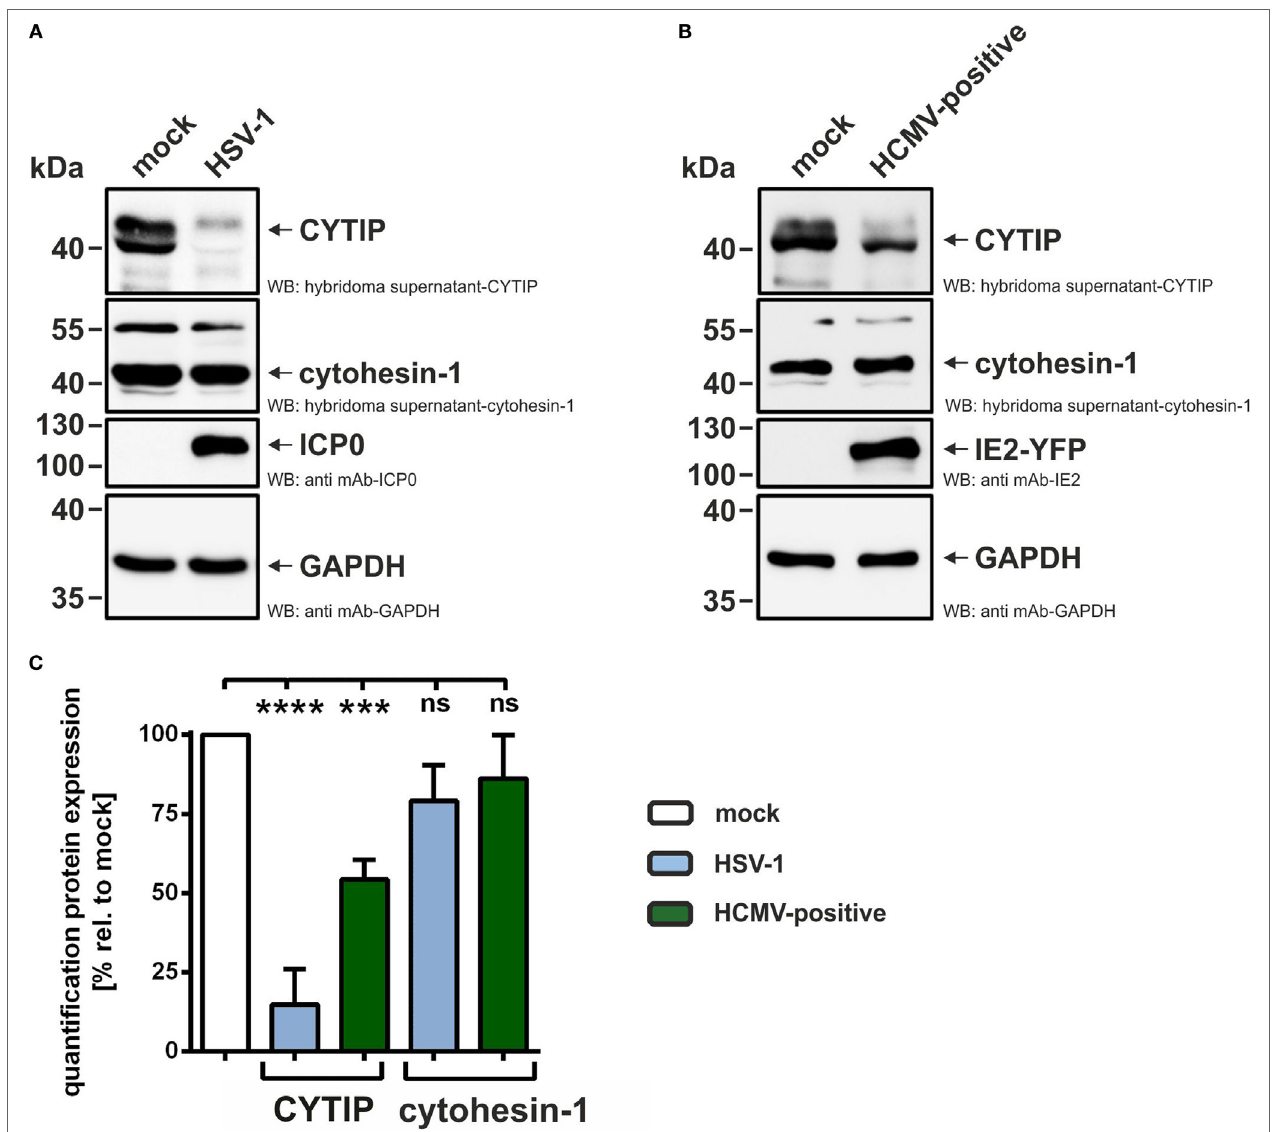
FigUre 4 | human cytomegalovirus (hcMV) infection of mature dendritic cells (mDcs) leads to decreased cYTiP expression levels . (a) mDCs were either mock- or herpes simplex virus type 1 (HSV-1)-infected and harvested 24 hpi, (B) mock- or HCMV-infected and sorted based on their green fluorescence protein expression 24 hpi. (a,B) Protein lysates were prepared and subjected to Western blot analyses with antibodies specific for CYTIP, cytohesin-1, ICP0, IE2, or GAPDH. One representative experiment out of at least three is shown. (c) Quantification of CYTIP and cytohesin-1 protein expression levels in HSV-1-infected or HCMV-positive mDCs, summarizing at least three independent experiments. Expression of CYTIP and cytohesin-1 was normalized to the GAPDH control. Mock was set to 100%. Significant changes (**** = p < 0.0001; *** = p < 0.001) are marked by asterisks, non-significant changes ( p > 0.05) as